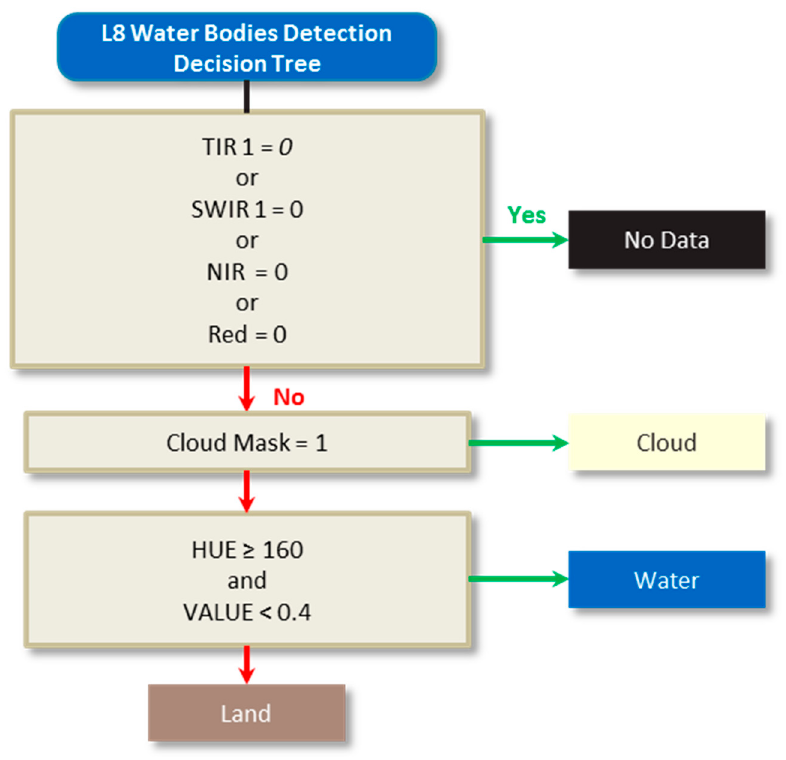
Figure C2. Decision Tree Classifier for WB detection on Landsat 8 images. A check on different bands and on cloud cover removes incompatible pixels from the scene. A check on HUE and VALUE is used to detect water bodies.